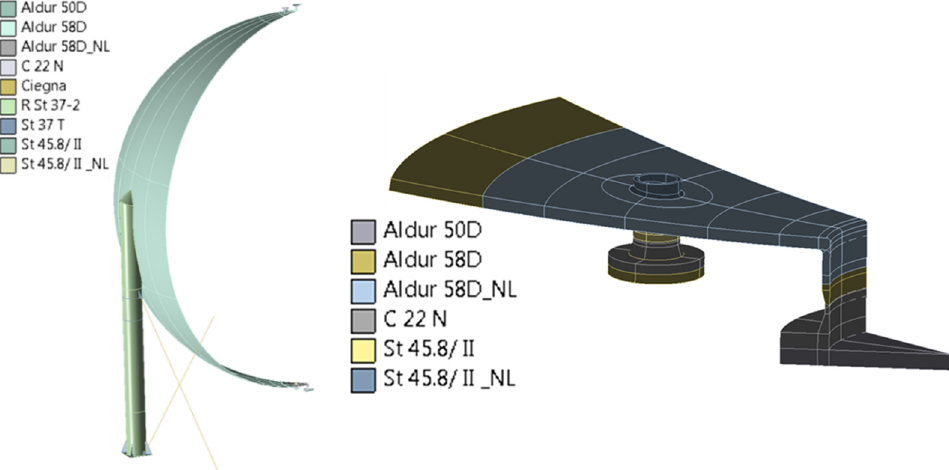
Figure 8. Distribution of materials with nonlinear characteristics on the vessel structure model in the lower manhole and nearby stubs (the designation NL next to the name of the steel grade means a nonlinear material model).